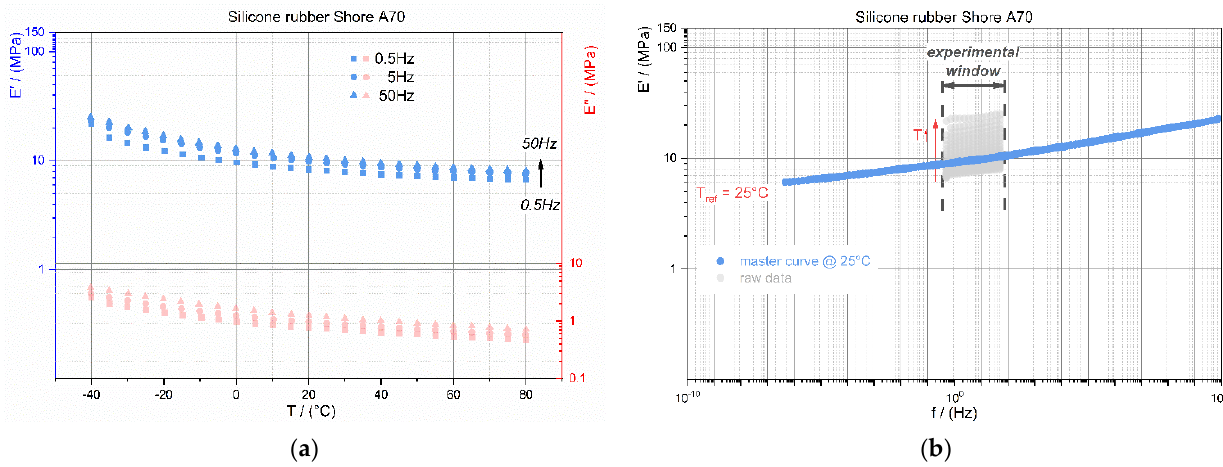
Figure 17. DTMA analyses for LSR Shore A 70 (tempered at 150 °C for 2 h) ; ( a ) loading frequency and temperature dependent storage and loss modulus (E ′ and E ′′ ); ( b ) calculated master curve for a certain nom. temperature.